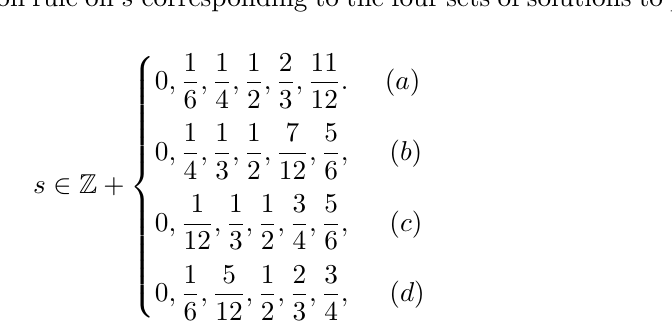
operator ( b Y ) acting on H is de(cid:12)ned in the upper right (cid:12)gure of (cid:12)gure 39 with the (cid:0) Y ij marked legs